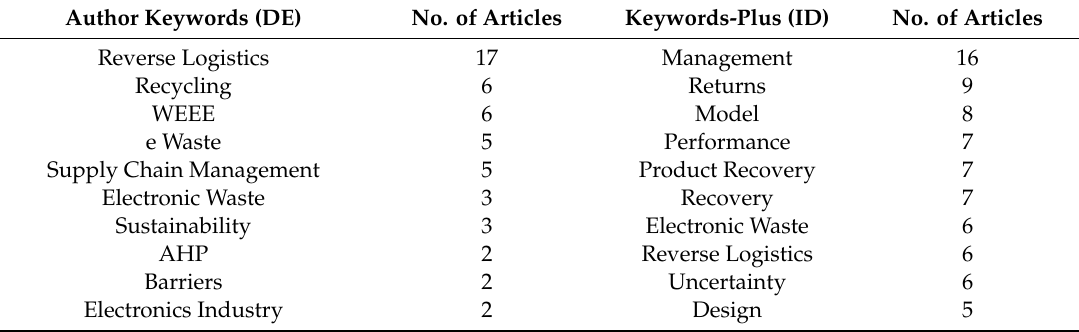
Table 4. Descriptive analysis: Top 10 most frequent keywords.